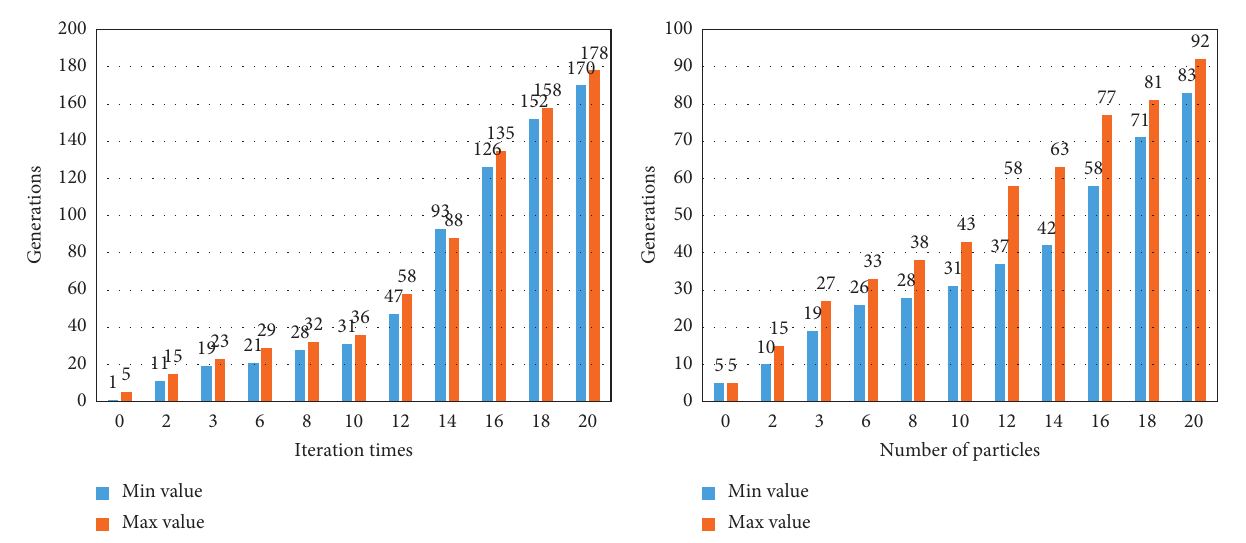
Figure 4: Simulation results of normal distribution. Table 2 lists the regression analysis results of the basic